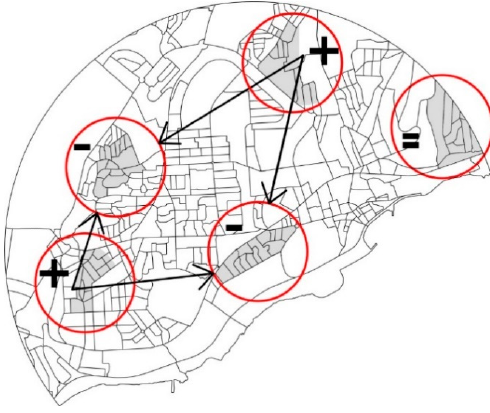
Figure 1. Conceptual model.